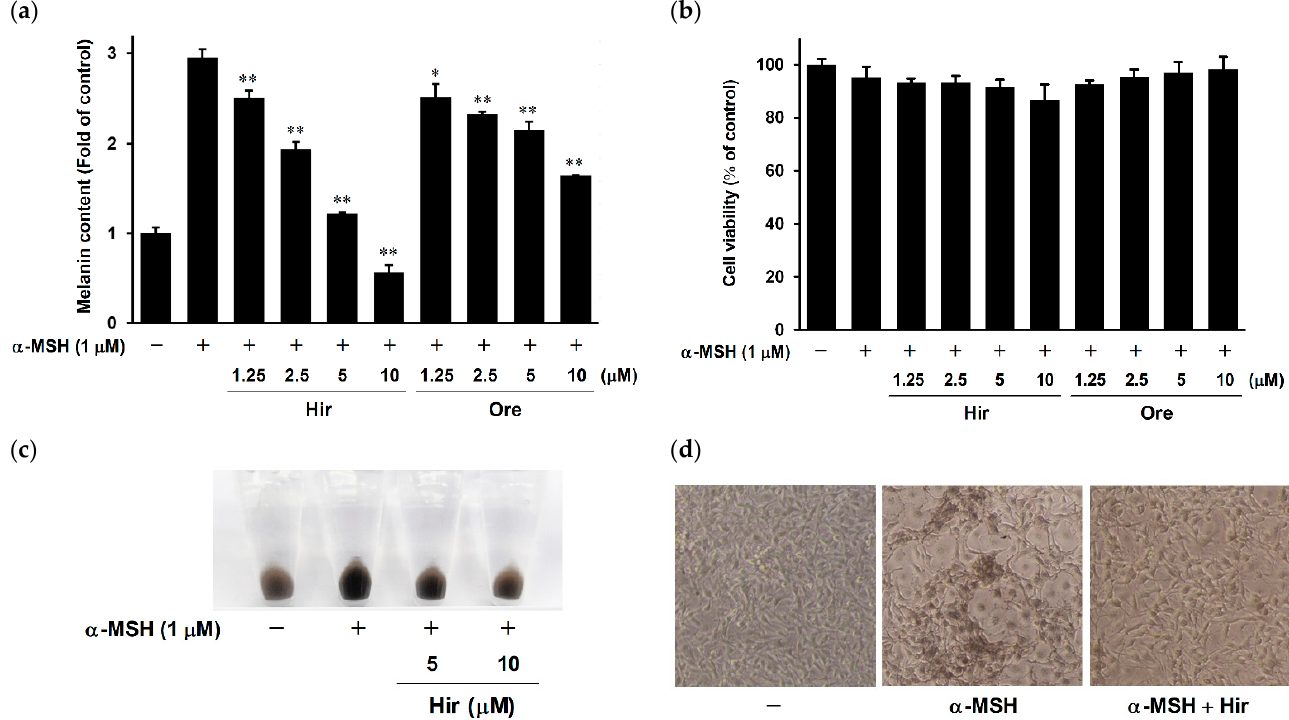
Figure 2. Effects of Hir and Ore on melanin synthesis and cell viability in B16-F1 cells. The cells were treated with Hir or Ore at the indicated concentrations for 1 h, then stimulated with α -MSH for 72 h. ( a ) Melanin content was determined as described in Materials and Methods. Values are the mean ± SD of three independent experiments. * p < 0.05 and ** p < 0.01 versus α -MSH. ( b ) Cell viability was determined as described in Materials and Methods. There were no significant differences between the α -MSH and experimental groups ( p > 0.05). ( c ) Photograph of cell pellets. ( d ) Microscopic views of cells.